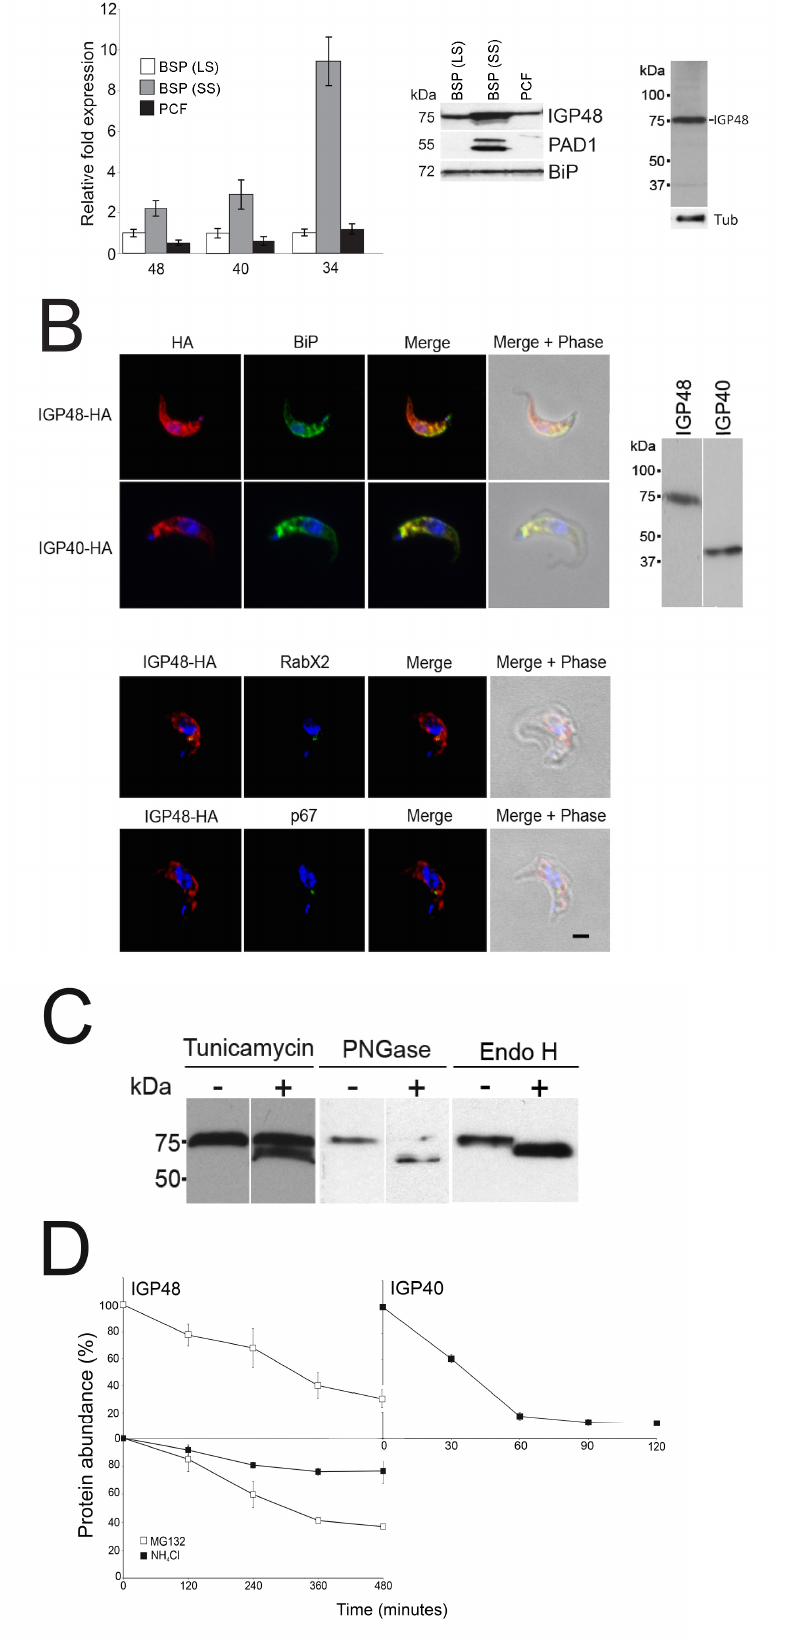
FIGURE 2: The IGP family are developmen- tally regulated ER proteins. (A) Copy num- bers of IGP48 [39], IGP40 [40] and IGP34 [34] mRNAs measured by qRT-PCR, in different life cycle stages, normalised to long slender BSF mRNA levels at 1.0. Error bars denote standard errors of the mean from triplicate measurements on independent RNA samples. Western blot of trypanosome whole cell lysates using anti-IGP48 affinity-purified anti- sera raised against E. coli -expressed recom- binant protein at 1:100 dilution. The blot was re-probed for PAD1 (protein associated with differentiation 1), and which is specifically unregulated in the stumpy bloodstream form, to validate the short stumpy lysate. Rightmost; whole cell lysate probed with anti-IGP48 antisera to validate specificity. Abbreviations: BSF (LS), long slender blood- stream form; BSF (SS), short stumpy blood- stream form and PCF, procyclic culture form. (B) Intracellular localisation of IGP48-HA and IGP40-HA in BSF cells under permeabilised conditions, and detected with anti-HA anti- body (red). Top panel: co-staining with anti- TbBiP (green). Lower panels: co-straining with anti-TbRabX2 and anti-p67 (green) using confocal microscopy. Bar = 2µm. Inset: ex- pression of IGP48-HA and IGP40-HA in 427 BSF cells detected by Western blotting using anti-HA antibody. (C) Digestion of IGP48 with PNGase F or Endo H, or treatment with tuni- camycin results in a large molecular weight shift. IGP48 was detected in fractionated lysates using anti-HA antibody. (D) Turnover of IGP48 and IGP40. Quantification of anti-HA reactivity in lysates of cells expressing IGP48- HA and IGP40-HA following inhibition of pro- tein synthesis with cycloheximide. Error bars represent the standard deviation and values were normalised against a loading control, BiP (n =